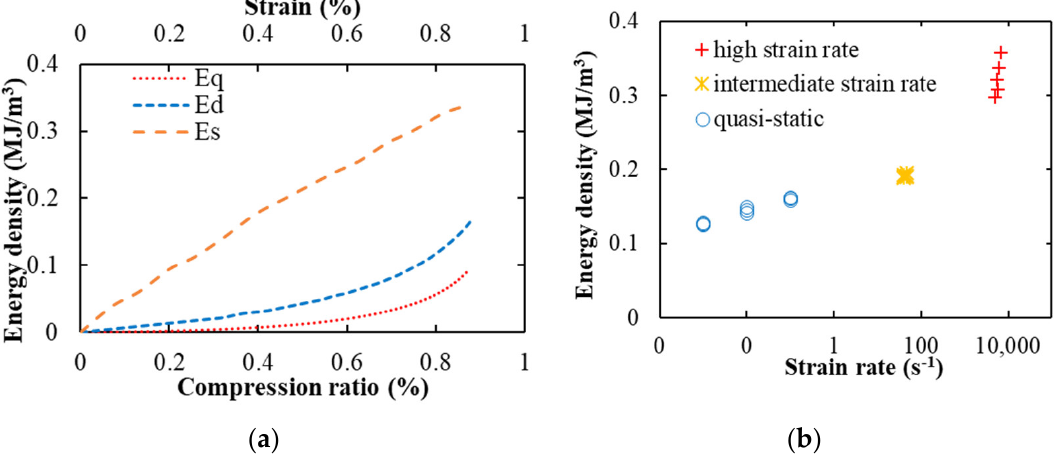
Figure 11. The energy absorption of the foam under the different strain rates: ( a ) the diagram of the energy absorption as a function of the compression ratio, the red line (E q ) represents the energy absorption of the foam in the hydraulic test, the blue line (E d ) represents the energy absorption of the foam in the drop weight test, and the orange line (E s ) represents the energy absorption of foam in the shock tube test; ( b ) the energy absorptions of the foam under the different strain rates, here, the energy absorption value was greatly affected by velocity under the shock mode.